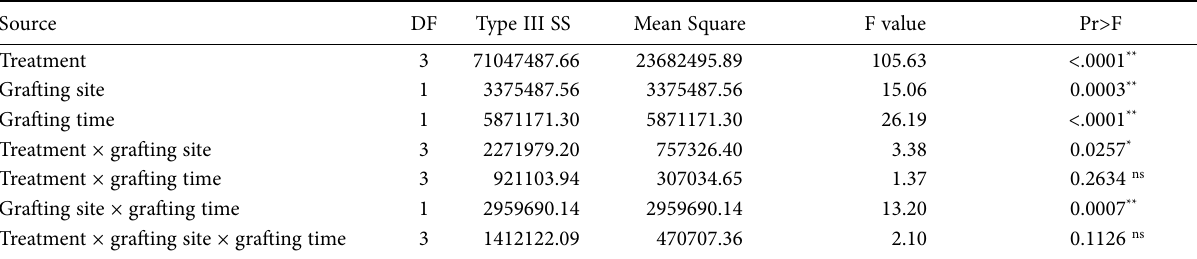
Table 3. Analysis of variance (using SAS 9.3 software) of areas under concentration growth curves of LWBP in mixed and singly grafted periwinkle plants.